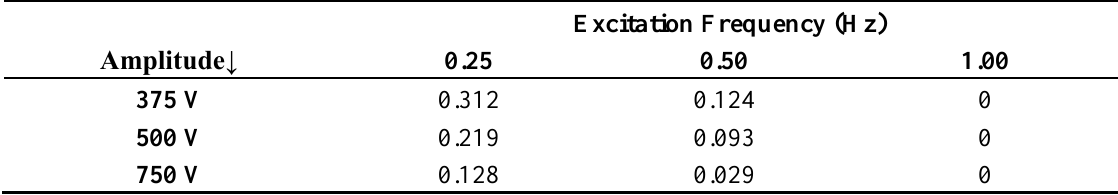
Table 9. Variation of the stiffness matrix coefficient